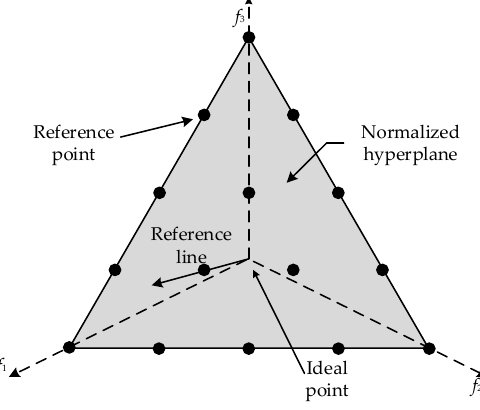
Figure 3 . Reference points on a hyperplane. Figure 3. Reference points on a